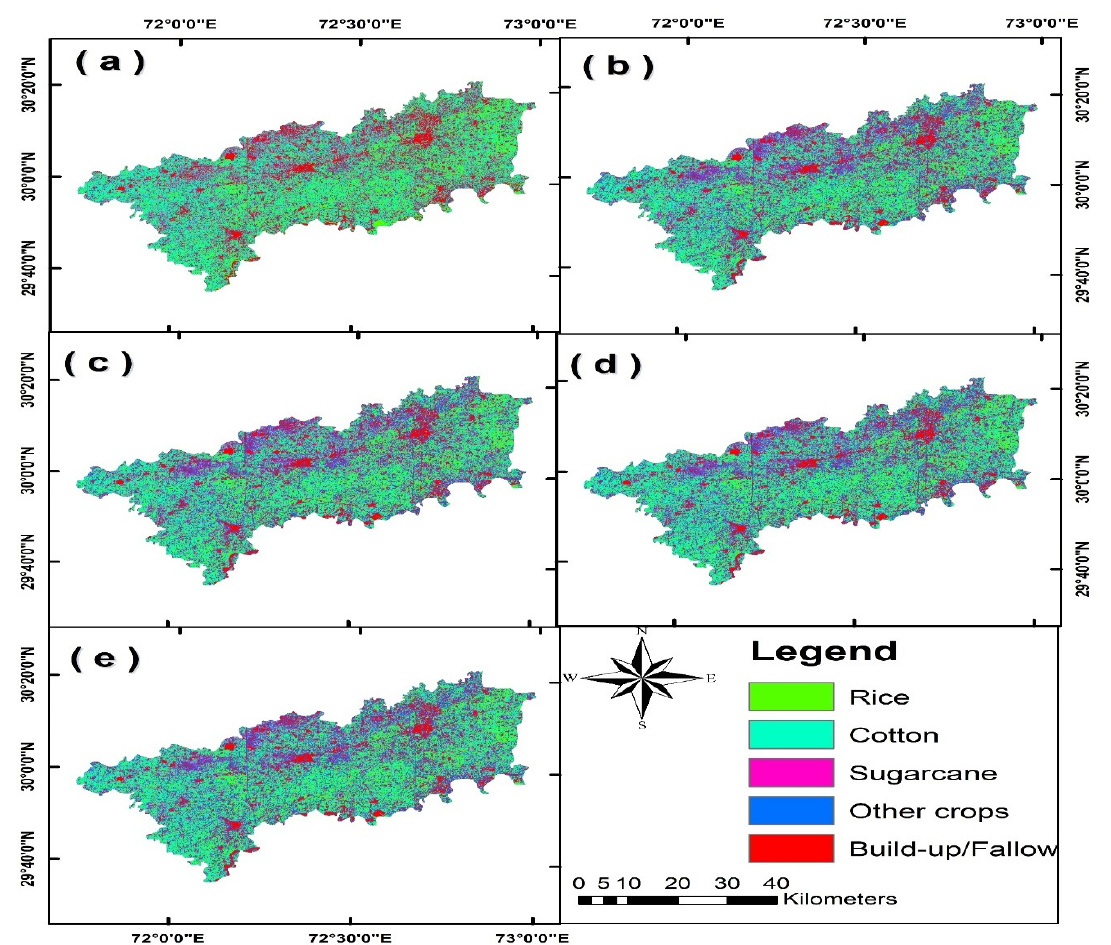
Figure 6. Crop identification map for Kharif season ( a ) 1984 ( b ) 1993 ( c ) 2002, ( d ) 2011 and ( e ) 2020.